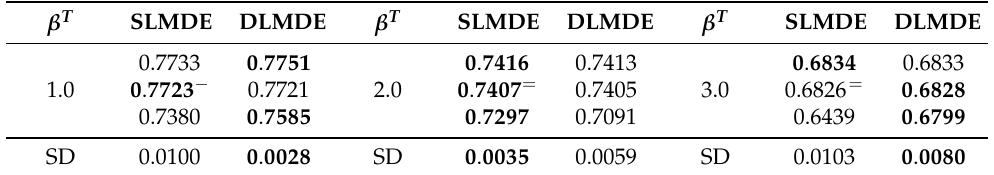
Table 9. Best, median, and worst HV values obtained by both methods are presented for example 4 for different values of β T . The best performances are highlighted in bold font.